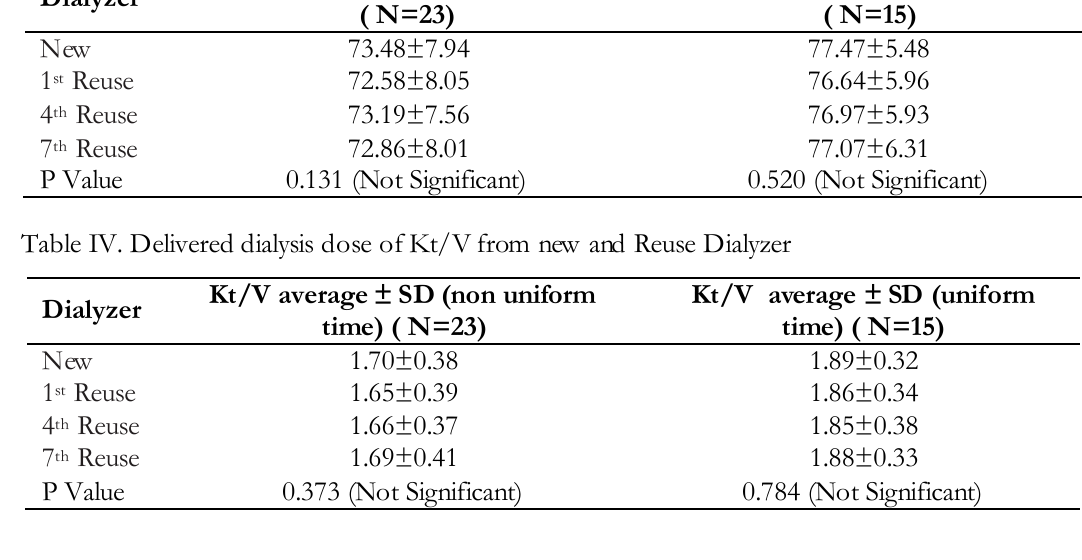
Table III. Delivered dialysis dose of URR from new and reuse dialyzer Dialyzer